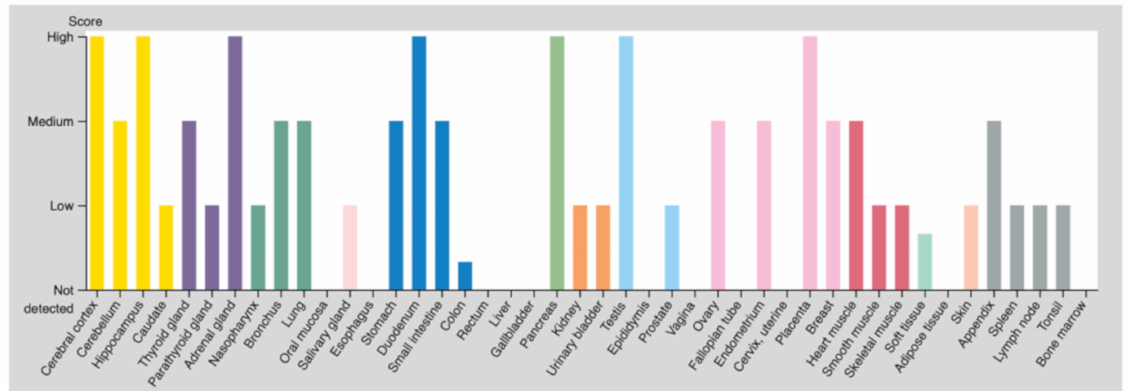
Figure 1. Transient receptor potential vanilloid 4 (TRPV4) (protein) expression overview. Color-coding is based on tissue groups, each consisting of tissues with functional features in common. From the Human Protein Atlas